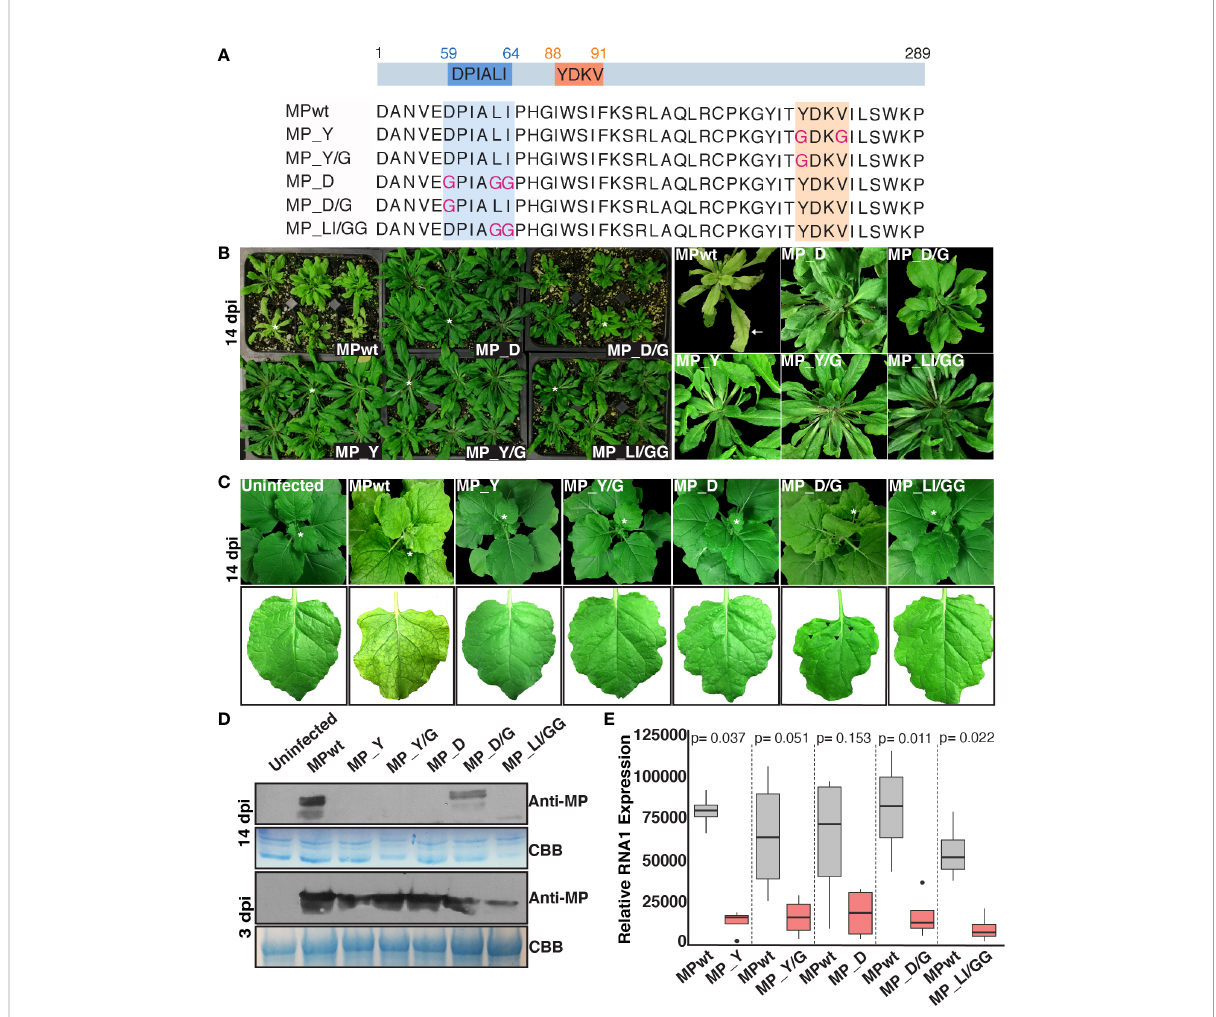
FIGURE 2 Loss of infectivity and reduced viral replication of OuMV carrying Y and LL motif MP mutants. (A) Schematic representation of constructs used in this study. Boxes indicate Y and LL motifs, and mutated sites are shown in pink. The illustration was created with BioRender.com. (B, C) Viral symptoms on Arabidopsis (B) and N. benthamiana (C) agroin fi ltrated with pGC-RNA1 (RdRp), pGC-RNA3 (CP), and pGC-RNA2 (MP) with indicated mutations, or sterile water (mock) at 14 dpi. White asterisks denote leaves shown in close-up images. Black arrowheads indicate mosaic symptoms on N. benthamiana infected with OuMV carrying MP_D/G. The background was removed from the images. (D) Western blot analysis of agroin fi ltrated leaves at 3 dpi (bottom panel) and upper uninoculated leaves at 14 dpi (top panel). CBB: Coomassie Brilliant Blue, loading control. (E) Replication assay of OuMV carrying Y and LL motif MP mutants at 48 hpi. Two leaf spots from three leaves were pooled for each sample at 24 hpi and 48 hpi. The qPCR was performed in duplicates. The 2 - DD Ct method was used to assess fold changes in replication of wild-type and mutants. The data was normalized fi rst using 18S ribosomal RNA, and then a wild-type control at 24 hpi showing the lowest expression. Box plot represents the relative expression of RNA1 (n=4). The statistical analysis was performed on DD Ct values using Student ’ s t- test (unpaired,